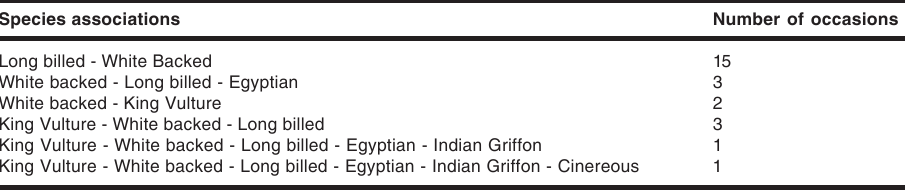
Table 2. Multiple associations among different species of vultures recorded in Pench Tiger Reserve (2006-2008) Species